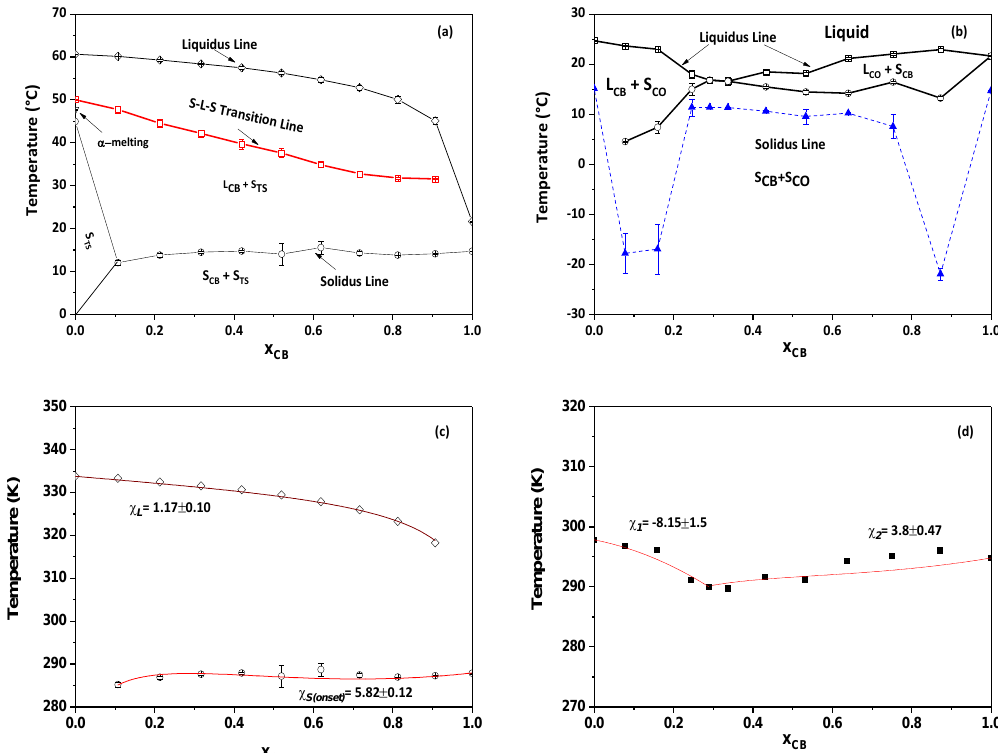
Figure 7. Comparison between pseudophase diagrams of ( a ) CB / TS blends ( b ) CB / CO blends. CB / TS phase diagram depicts a monotectic mixture of CB / TS, whereas CB / CO shows a eutectic mixture at X CB = 0.35. ( c , d ) represents the fitting of phase diagram by using Bragg–Williams approximation for CB / TS and CB / CO blends, respectively.